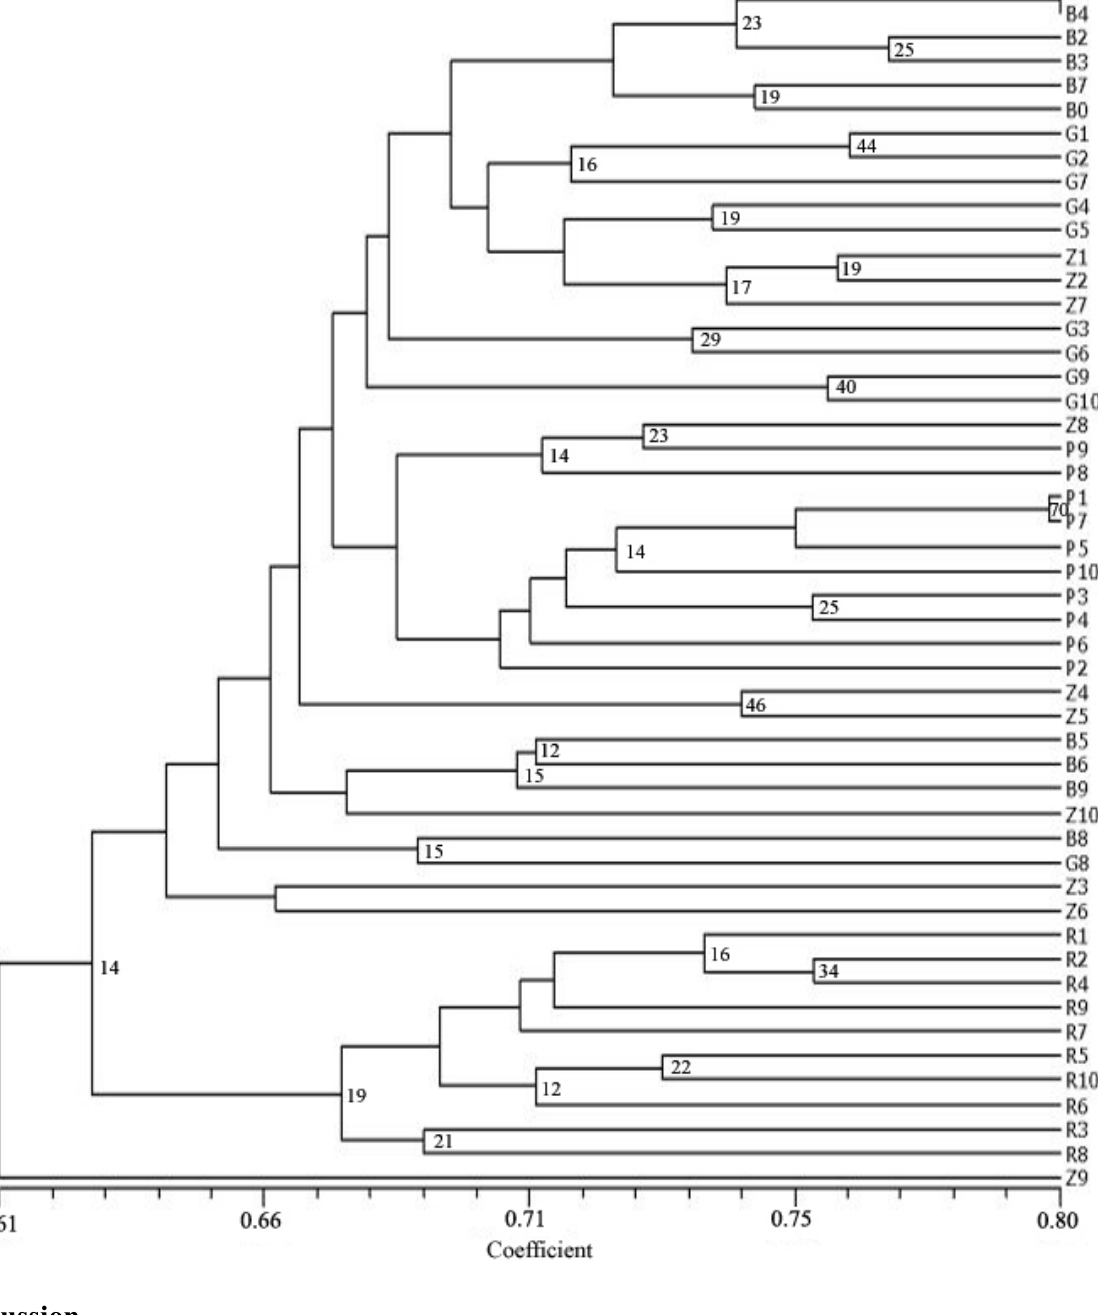
Figure 3. Dendogram of 50 individual samples based on unweighted pair group arithmetic mean method cluster analysis of Jaccard’s similarity coefficient. (B1-B10-Banat, G1-G10-Ghareh, Z1-Z10-Zuzana, P1-P10-Pecy, R1-R10-RSI 20). Numbers represent bootstrap confidence limits for 1000